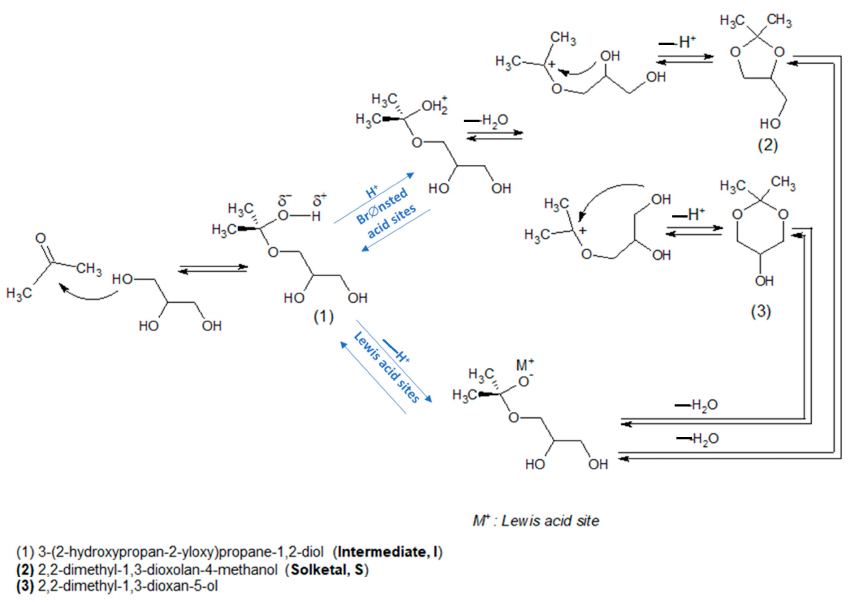
Figure 28. Reaction mechanism proposed for the acetalization of glycerol with acetone over acid catalyst. Adapted with permission from [231] Copyright © 2014, American Chemical Society.